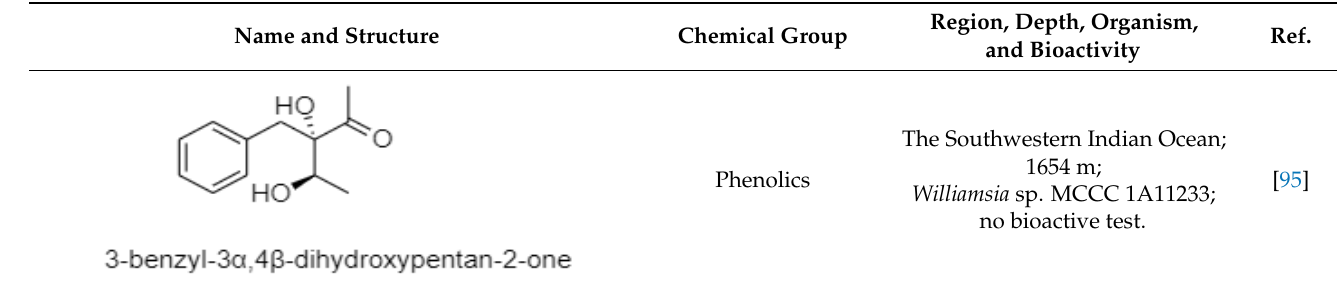
Figure 1. Maximum-likelihood tree of the novel species of actinobacteria isolated from deep-sea samples (constructed using MEGA11 software, Pennsylvania, USA, available from www.megasoftware.net.) [115]. The phylogenetic tree was constructed using the 16s rRNA gene sequence of 24 novel actinobacteria with GenBank/EMBL/DDBJ with accession numbers of KT751084, KT751085, KF914155, JF346427, KX356313, NR_174342, OK039348, KT751087, MN463006, NR_173679, MT036271, MW003705, AY894337, NR_170401, KT751086, KT751083, NR_180167, NR_180166, NR_171428, NR_173654, NR_173655, MF919580, MN578142, and MN578150 (the number of nucleotide pairs varied across species). The evolutionary distances are computed using the Tamura 3-parameter model. Bootstrap percentage values are given for 100 replicates. Bar: 0.05 substitution per nucleotide position. Table 2. New compounds of actinobacteria from deep-sea niches reported between 2016 and 2022. Name and Structure